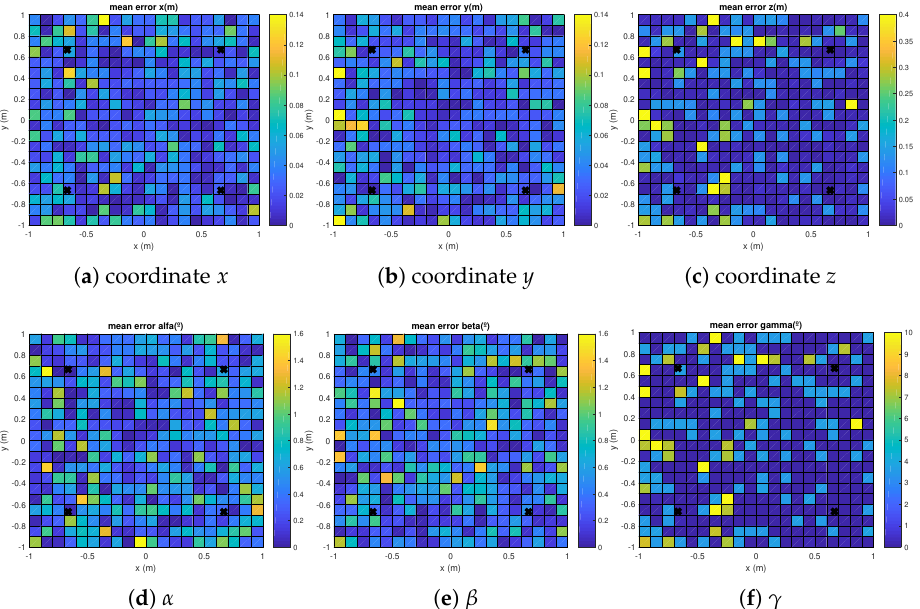
Figure 3. Mean absolute errors in the grid of considered points in the floor for the EPnP algorithm and a rotation in the Z axis γ = 120 ◦